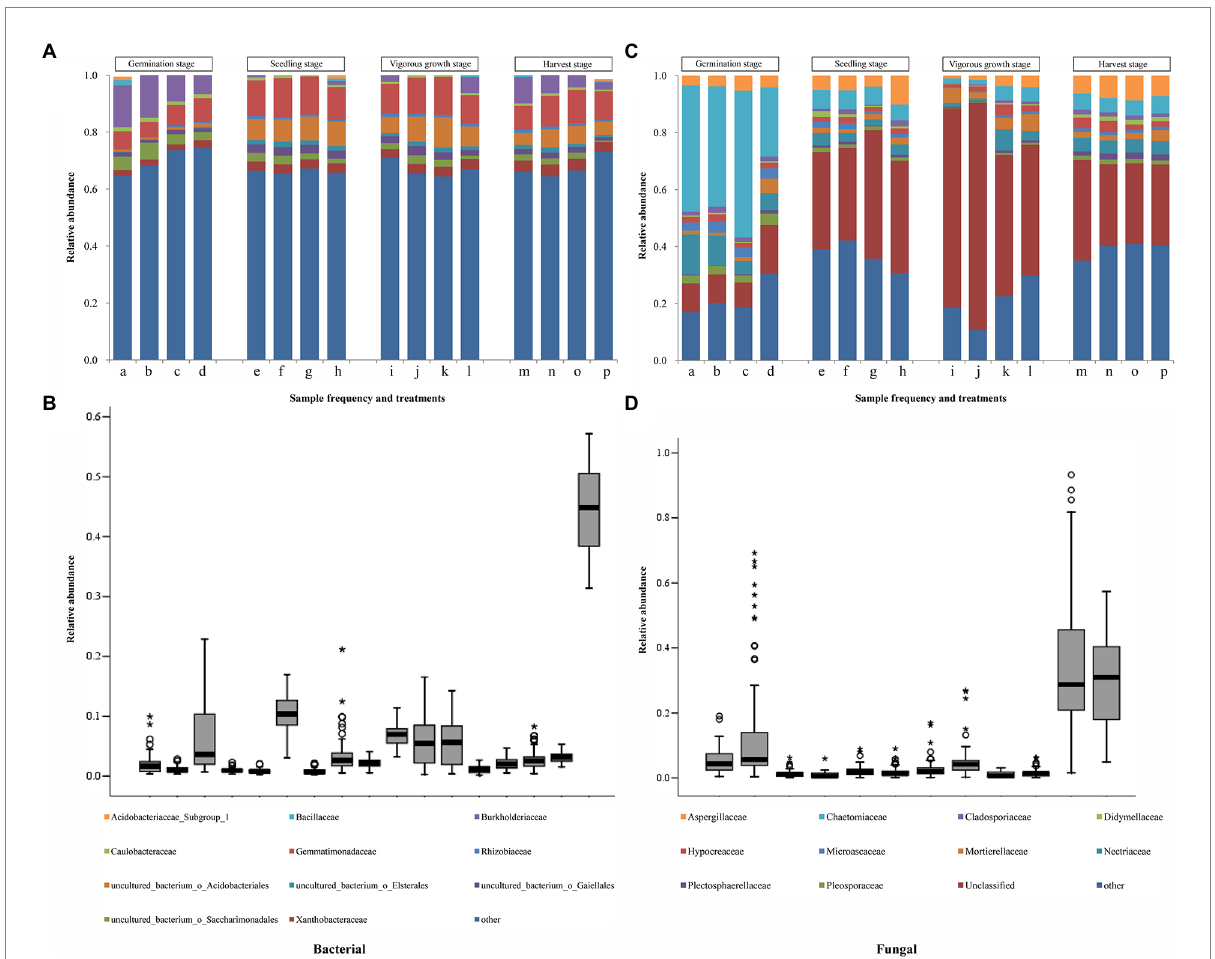
FIGURE 3 Taxonomic structures of soil bacterial and fungal populations at the family levels. (A) and (C) Taxonomic structures of soil bacterial and fungal populations. a, e, i, and m represent the soil samples treated with R. palustris PSB-06 and dazomet. b, f, j, and n represent the soil samples treated with dazomet alone. c, g, k, and o represent the soil samples treated with R. palustris PSB-06 alone. d, h, l, and p represent the soil samples without treatment (blank control). Only the 16 bacterial families (A) , and the 11 fungal families (C) , with the highest mean relative abundance were shown. (B) Boxes showing the 16 bacterial families with the largest mean relative abundance. (D) Boxes showing the 11 fungal families with the largest mean relative abundance. The other bacterial and fungal families were all classified as “other.” The median value of a family was represented as a line in the box. The interquartile ranges covered the 75th to 25th percentiles. The whiskers were the inclusive of the maximal and minimal values without the outliers. The cycles and stars indicate the discrete and extreme values,